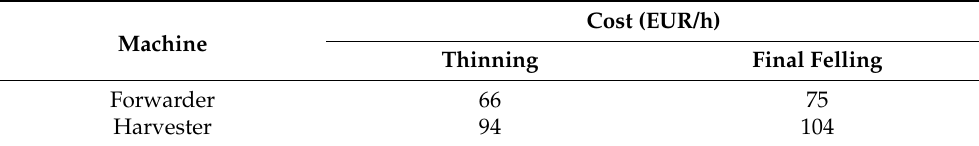
Table 2. Forwarder and harvester costs during thinnings and final felling.